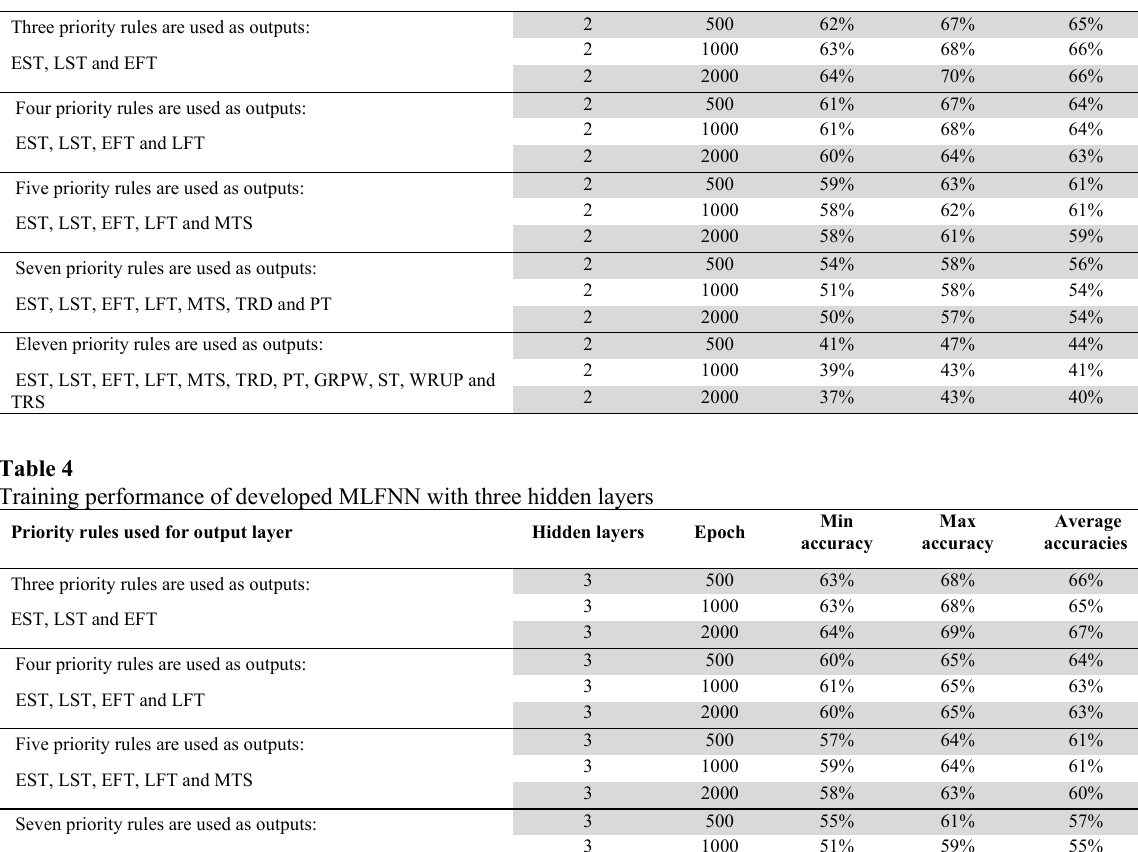
Max Average accuracy accuracies